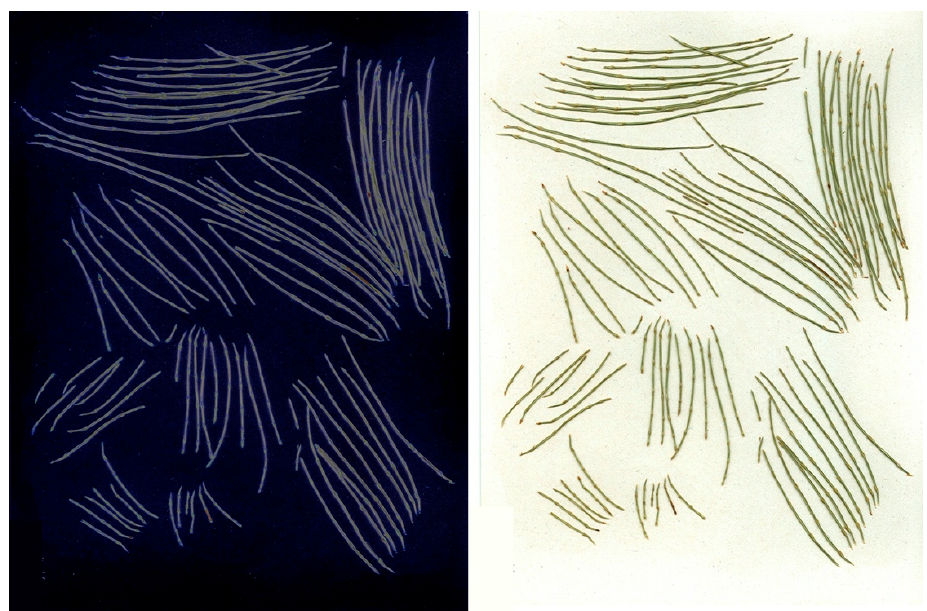
Figure 6. ‘Favourite tree leaves’, ( left ) a print and ( right ) plant specimens (Collins & Goto Studio 2019).